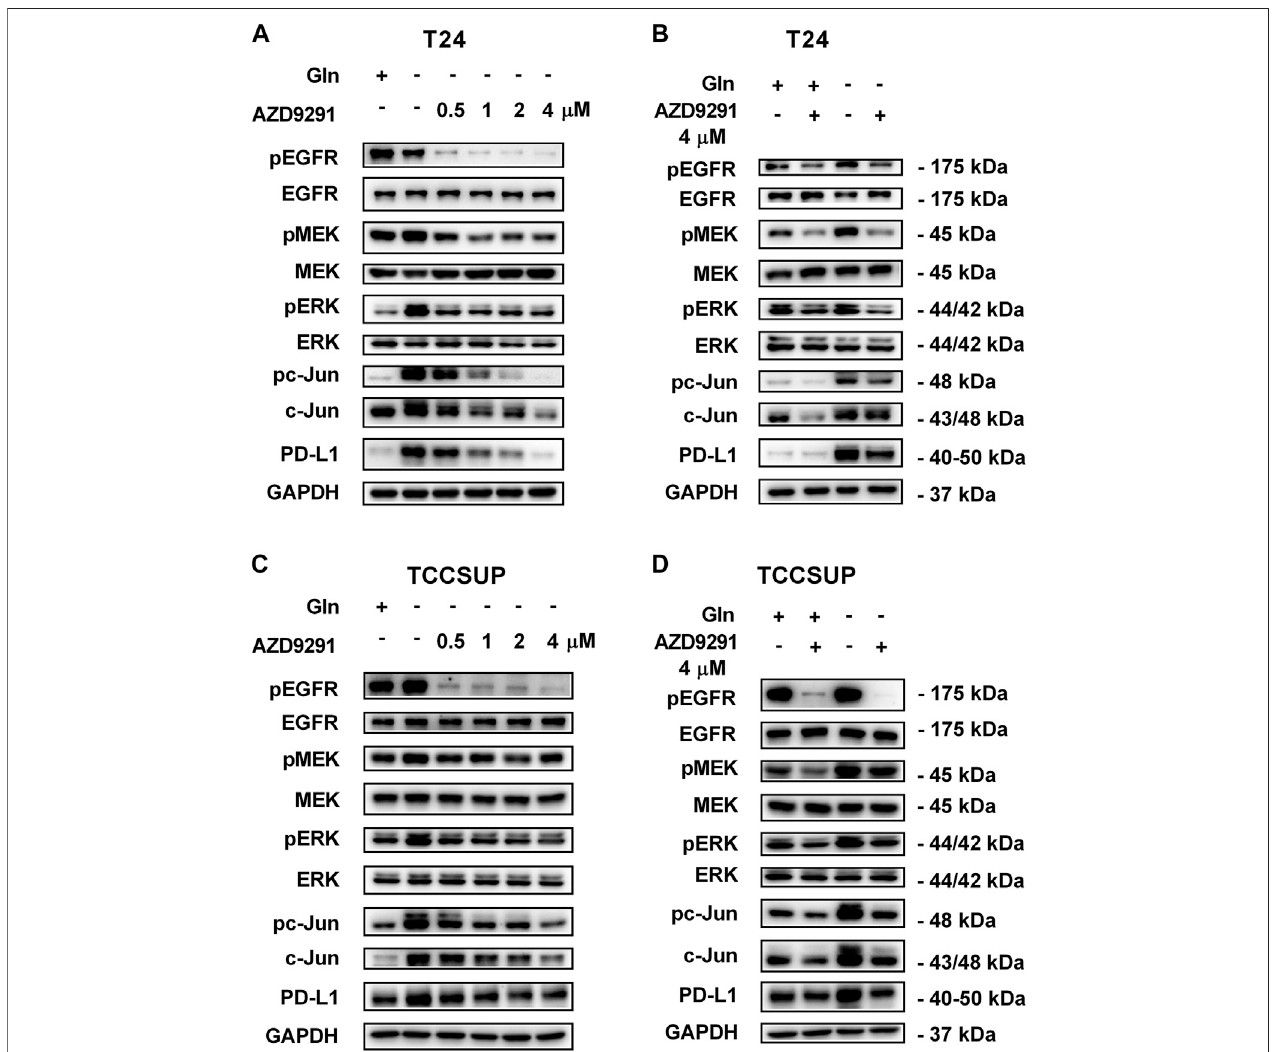
FIGURE 3 | Inhibiting EGFR activation can reduce the elevated PD-L1 level induced by glutamine deprivation in T24 and TCCSUP cells. (A) The protein levels of pEGFR, pMEK, pERK, pc-Jun and PD-L1 inT24cells cultured in glutamine-free medium with different concentrations ofthe pEGFR inhibitor (AZD9291: 0,0.5, 1,